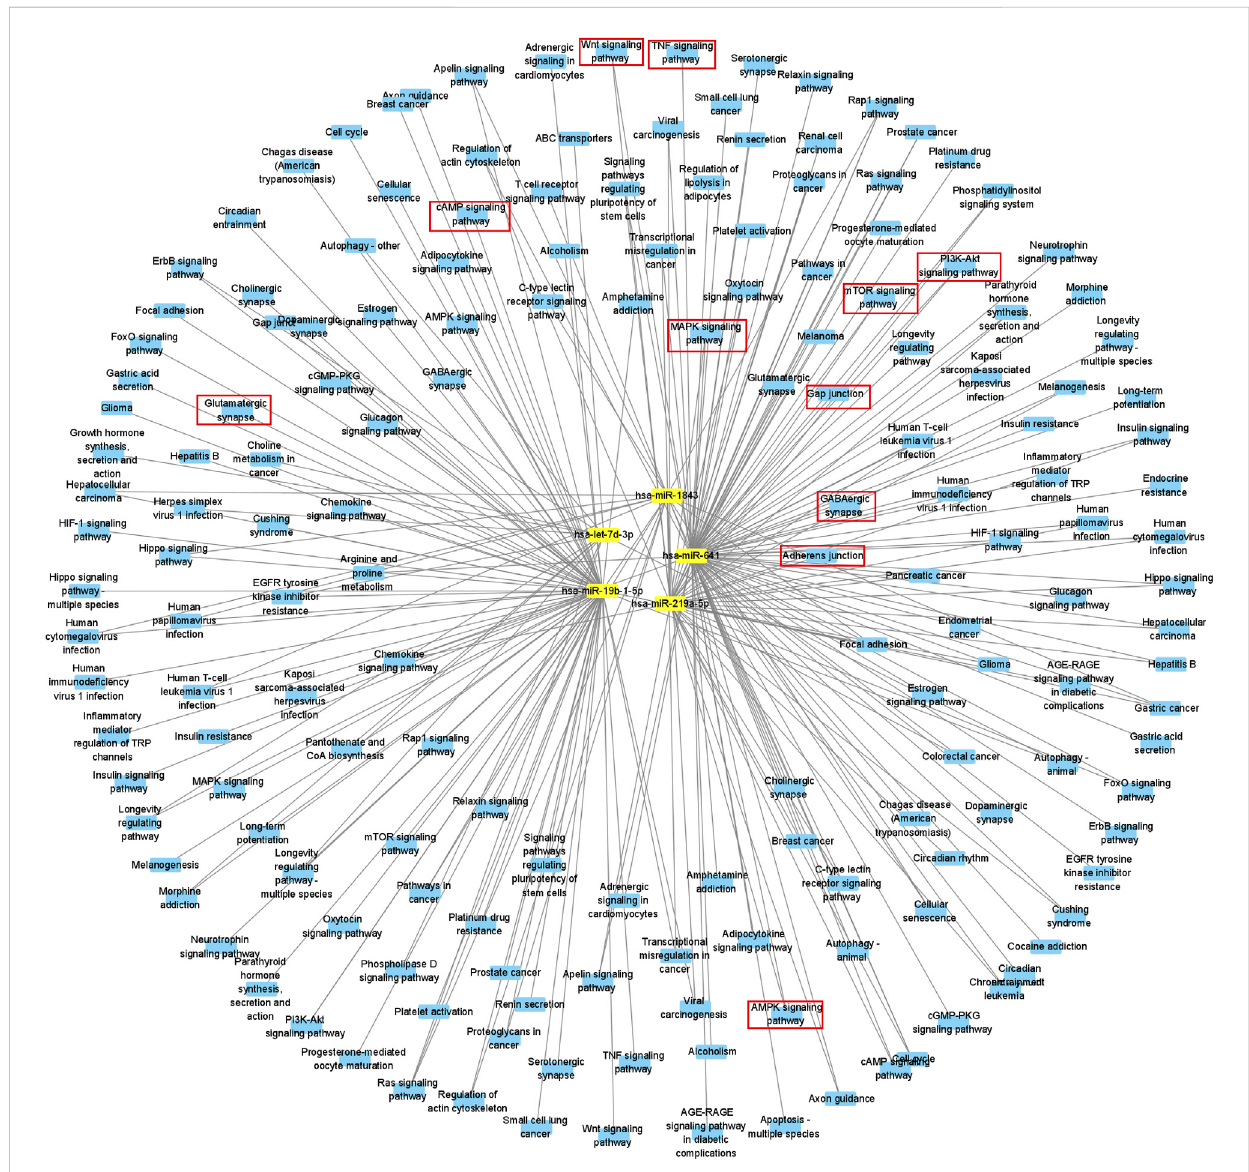
FIGURE 5 DiagramofadifferentialmiRNA-pathwaynetwork.MiRNAs aresymbolized byyellowsquares,miRNA-relatedsignalingpathwaysare fi lled withblue circles, and parts of critical key signaling pathways are marked with red